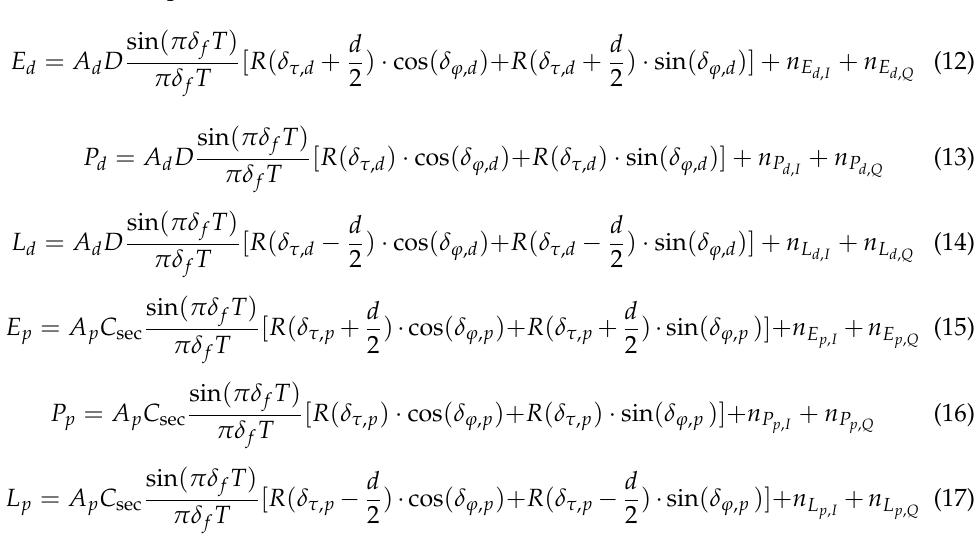
Figure 3. The framework of correlator joint receiving for B1C/L1C signals. The receiver correlator outputs early branch E, punctual branch P and late branch L,